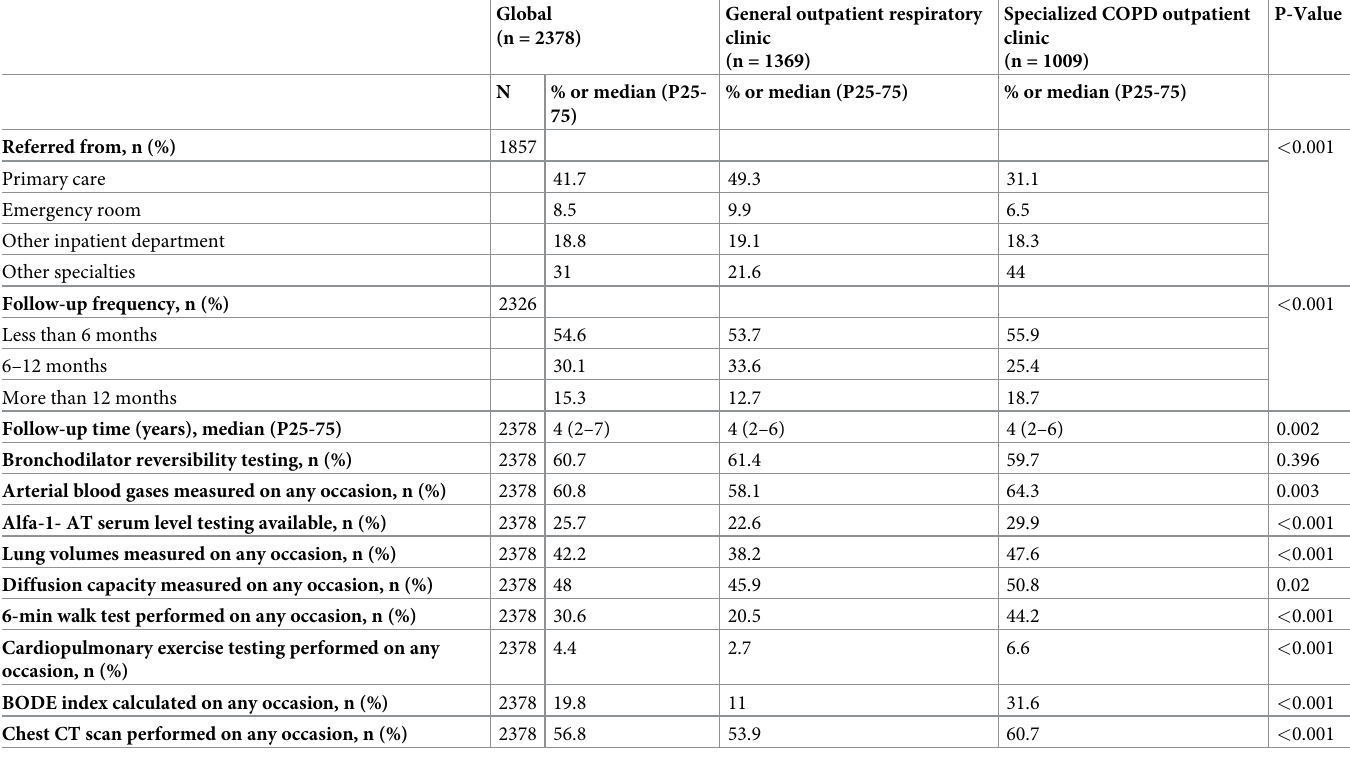
Table 4. Medical care and diagnostic procedures during follow-up in both outpatient clinic